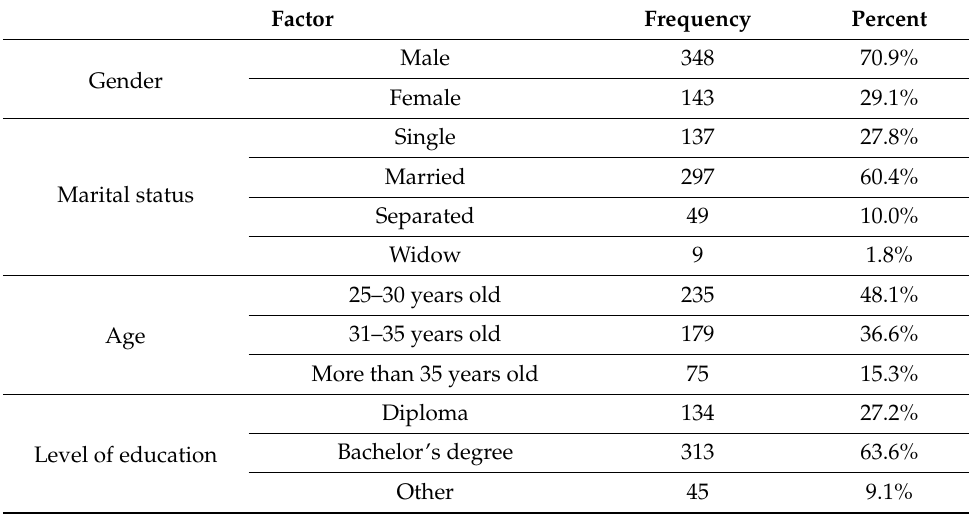
Table 1. Demographic factors of nurses ( n =